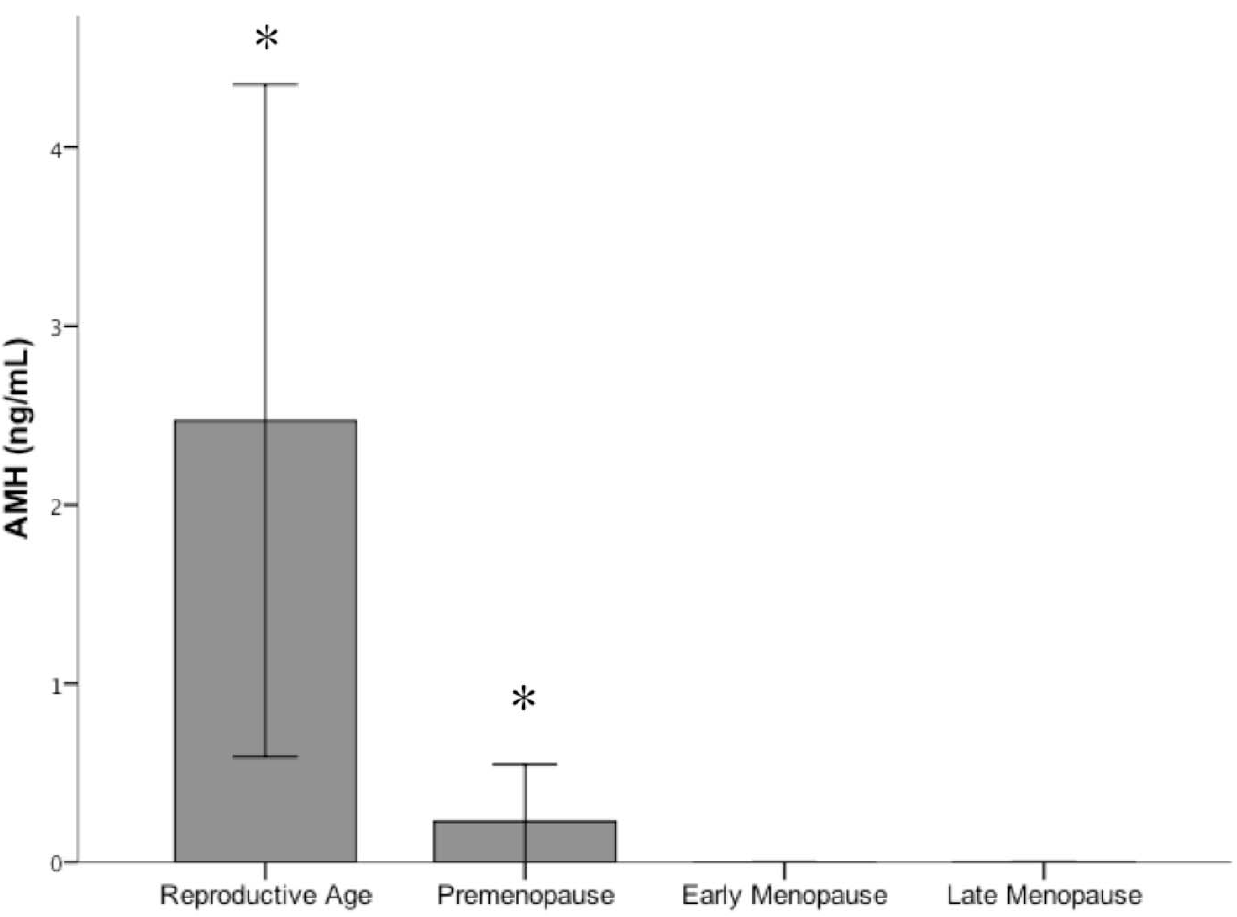
Figure 2. Mean serum levels of anti-mu¨llerian hormone (AMH) in women divided according to reproductive phases. AMH levels were significantly lower in premenopausal women in comparison with women in full reproductive age (p , 0.0001) and became undetectable in menopausal women (both early and late).